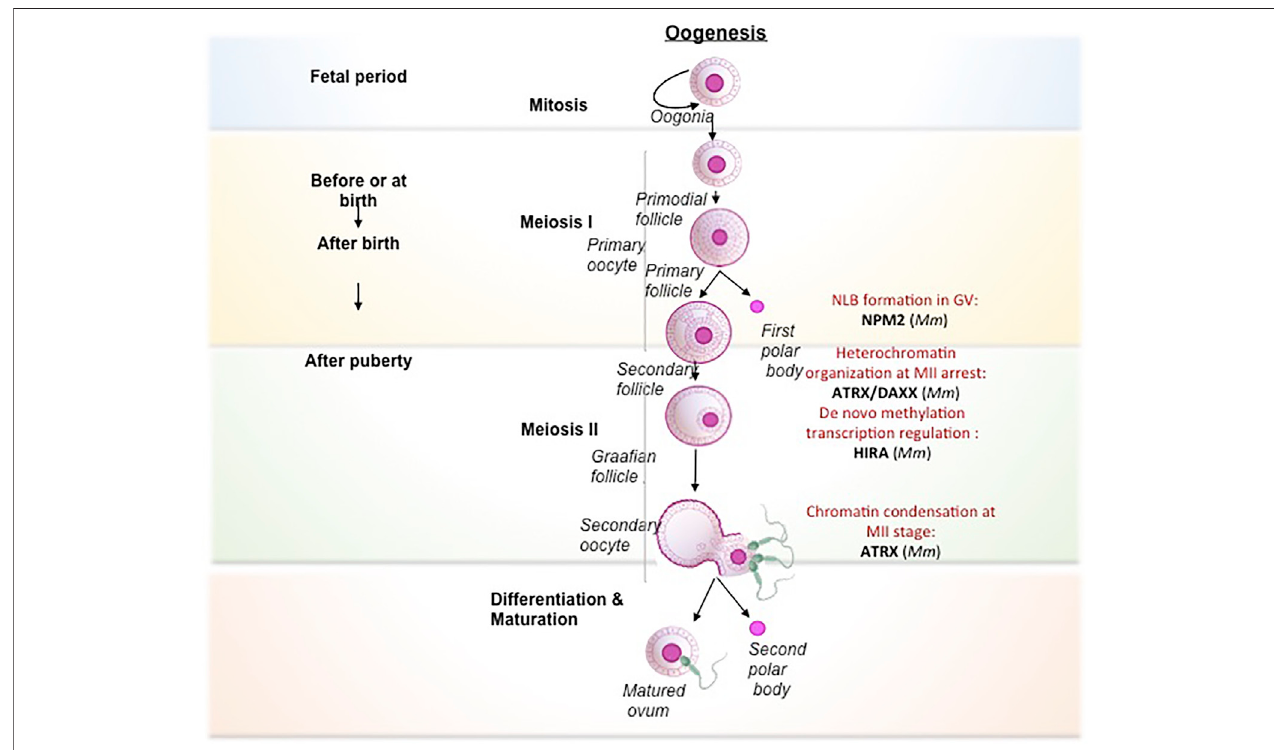
FIGURE 2 | Histone chaperones in different stages of oogenesis. Schematic representation of oogenesis has been depicted. The transformation from oogonia to ovum is subdivided into mitosis (self renewal of oogonial cells), meiosis I (reduction division), meiosis II (equational division similar to mitosis) and maturation (transformation to fertilization competent ovum). The primary oocyte gets arrested at Prophase I of Meiosis I in the fetal period and completes at the time of ovulation. Following that, the primary o/ocyte undergoes Meiosis II and gets arrested at Metaphase. The secondary oocyte thus formed resume to complete meiosis II only upon fertilization to form fully matured ovum. The functional implication of different histone chaperones in the corresponding stages of oogenesis is mentioned. The self renewal of oogonial cell is regulated by CAF1. NPM2 involves in the cortical granule formation and the NLB formation in the primary follicle. NAP1 deposits the B4 linker histone during meiosis I. The H3.3 chaperones, HIRA and ATRXX/DAXX involve in the heterochromatin formation and transcriptional regulation respectively while H3.1/ H3.2 chaperone, CAF1 facilitates the chromatin assembly. NPM2 involves in the regulation of oocyte competency for fertilization during the maturation phase. Abbreviation-Mm, Mus musculus